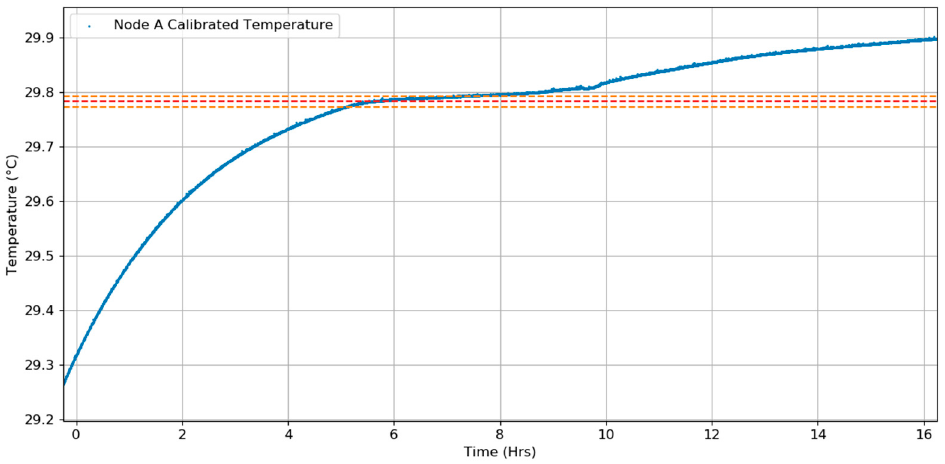
Figure 4. Early results for a melting point plateau of a phase change cell in the NGenIRS blackbody calibration source. The plot shows the temperature of a calibrated thermometer mounted on the base of the blackbody next to the phase change cell for a single melt during thermal testing of the prototype source.